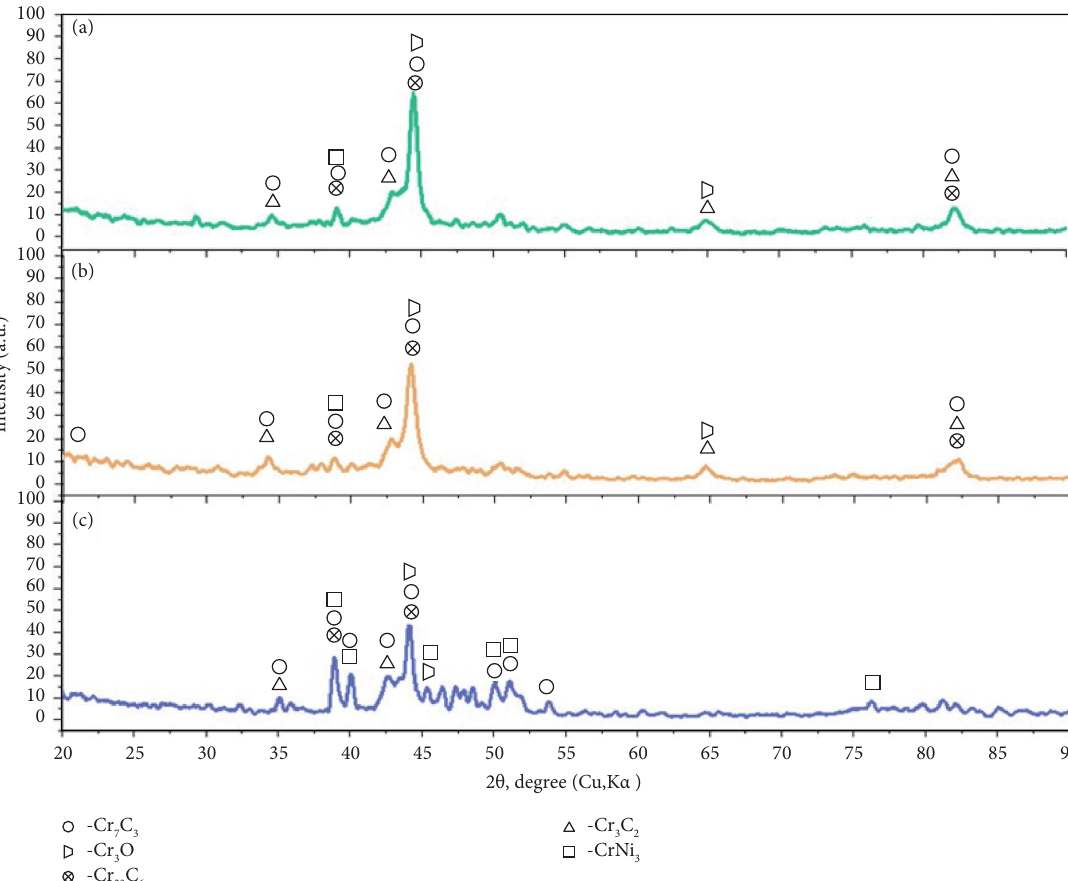
Figure 2: Surface difractograms of the Cr